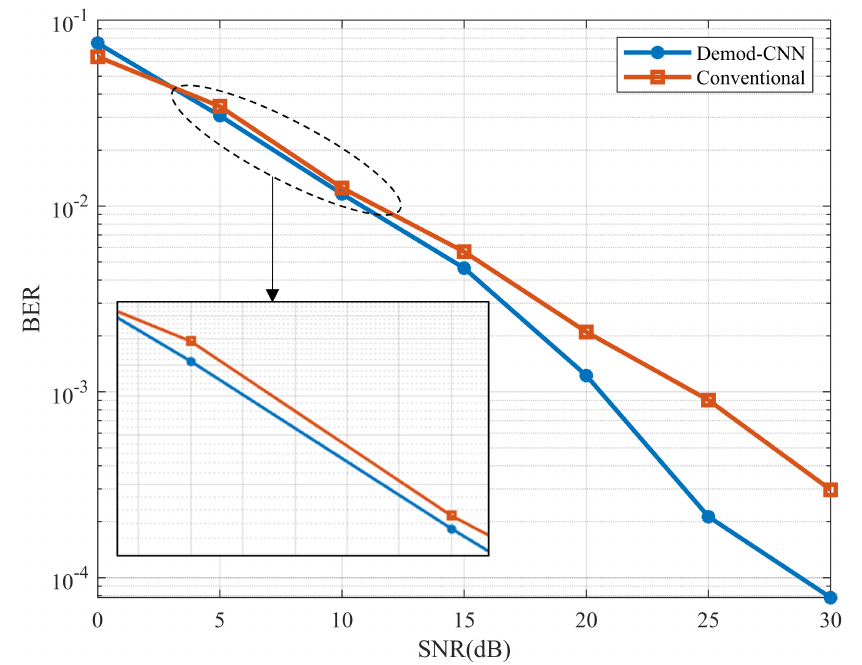
Figure 5. BER performance comparison of the proposed Demod-CNN and conventional technique.